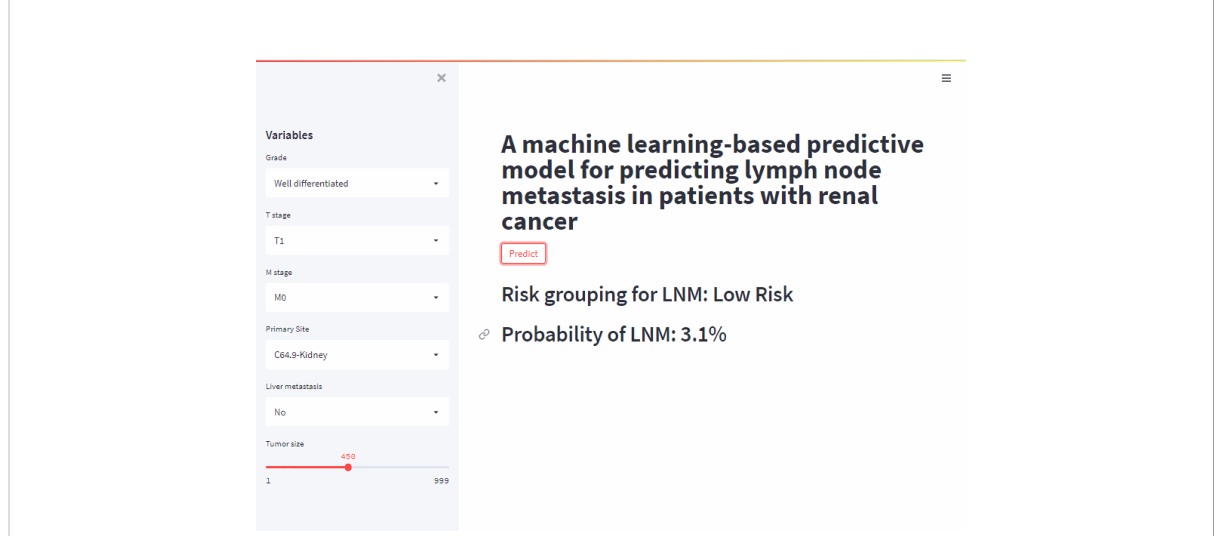
FIGURE 6 The web calculator for predicting lymph node metastasis in patients with